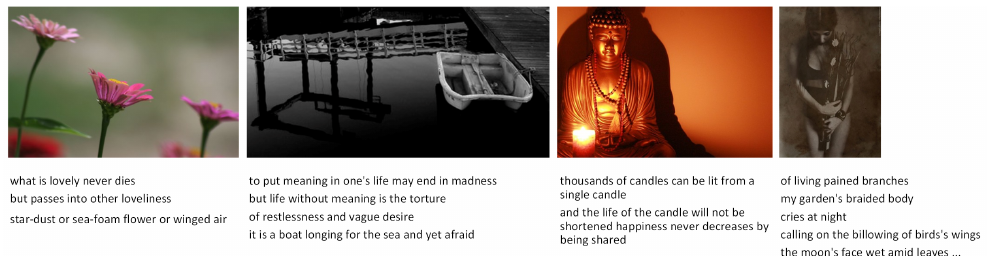
Figure 4. Sample image–poem pairs from MultiM-Poem